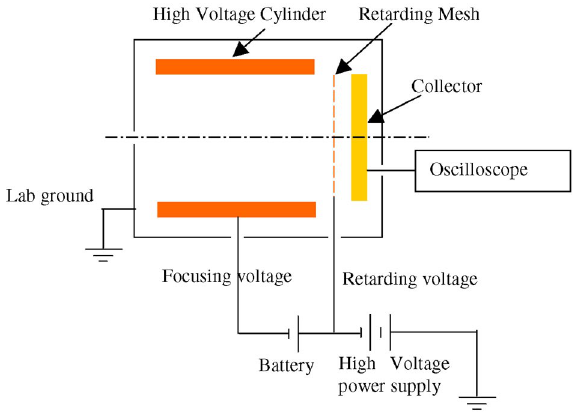
FIG. 2. (Color) The electrical circuit of the energy analyzer with variable-focusing cylindrical electrode.